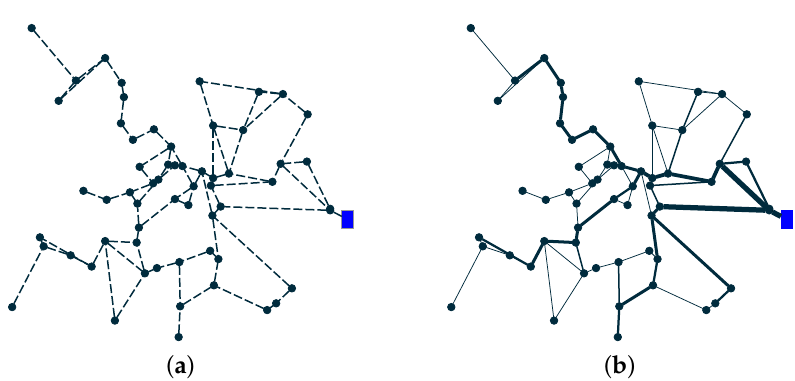
Figure 1. Example of the water distribution network design optimization problem for a small network. ( a ) Unoptimized network; ( b ) Optimized network. Thicker lines represent larger